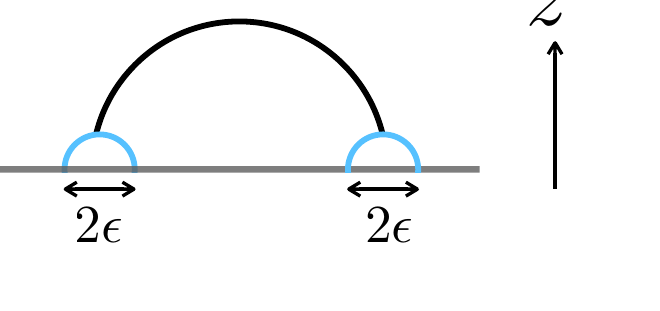
Figure 9 . Cutoff by introducing end-of-world branes (blue) corresponding to the entangling sur-